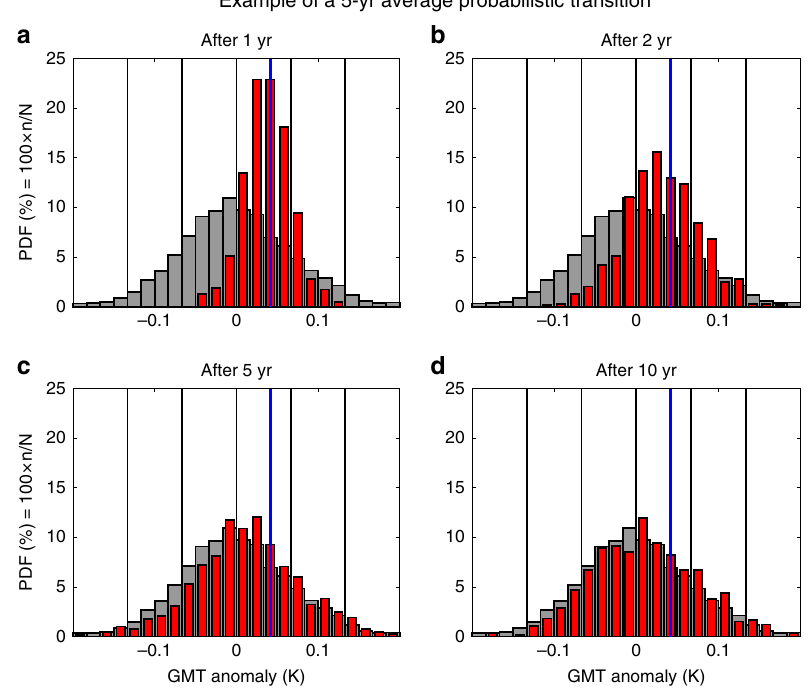
Fig. 3 Example of a probabilistic interannual prediction for 5-year GMT anomalies using the transfer operators. Evolution of the predicted density distribution of GMT for hindcast lags of a 1 year, b 2 years, c 5 years, and d 10 years (red histogram). Vertical blue lines indicate the initial condition; the gray histograms in the background represent the asymptotic, climatological distribution; vertical black lines correspond to the mean, ±1, and ±2 standard deviations of the asymptotic, climatological